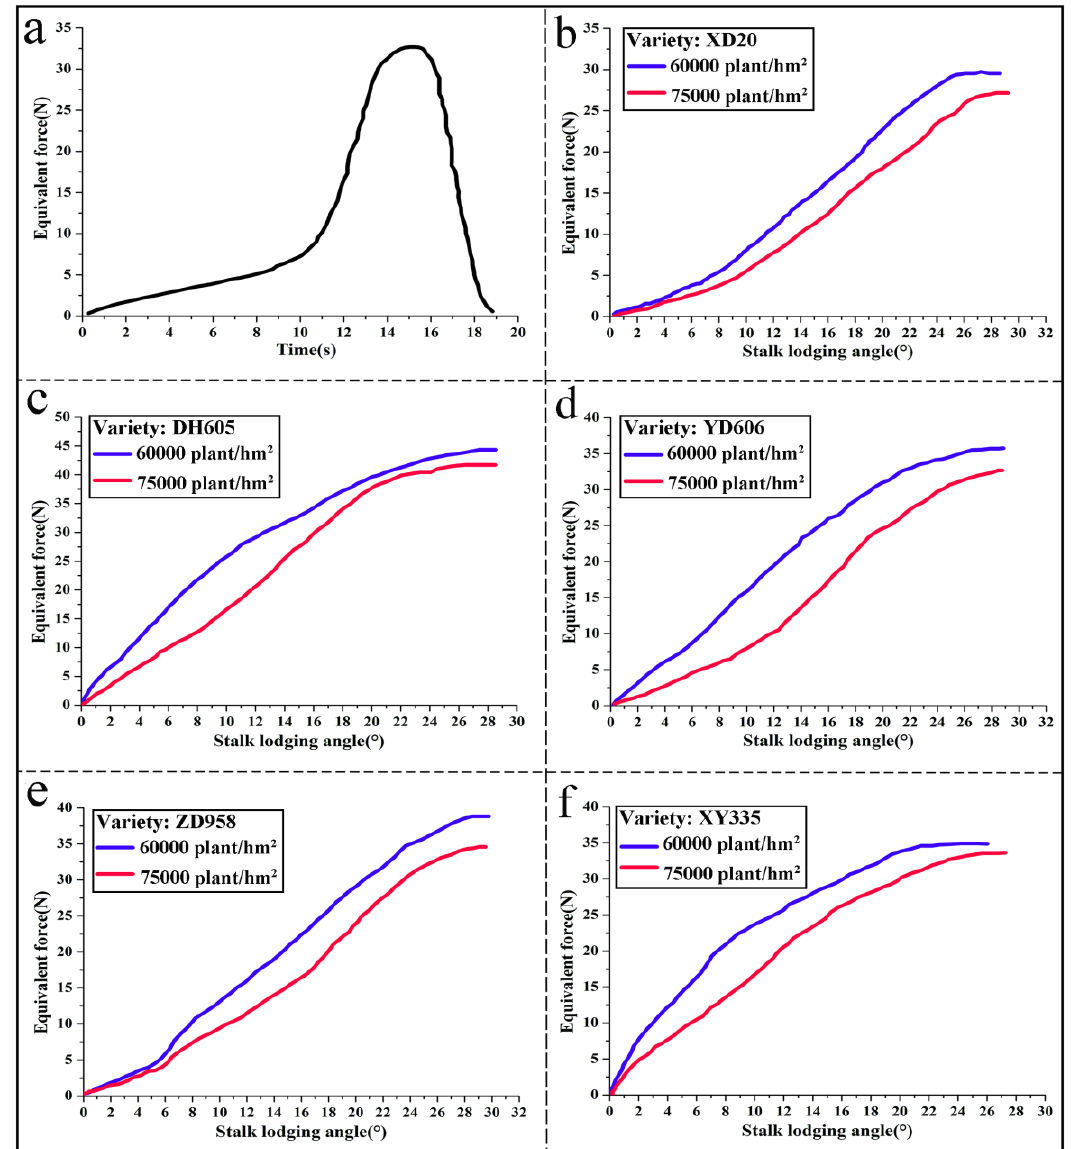
Figure 5. ( a ) Pull forces changing with the time in the process of corn stalk lodging; ( b – f ) the equivalent forces varying with corn stalk lodging angles for the five corn varieties with two planting densities, respectively.